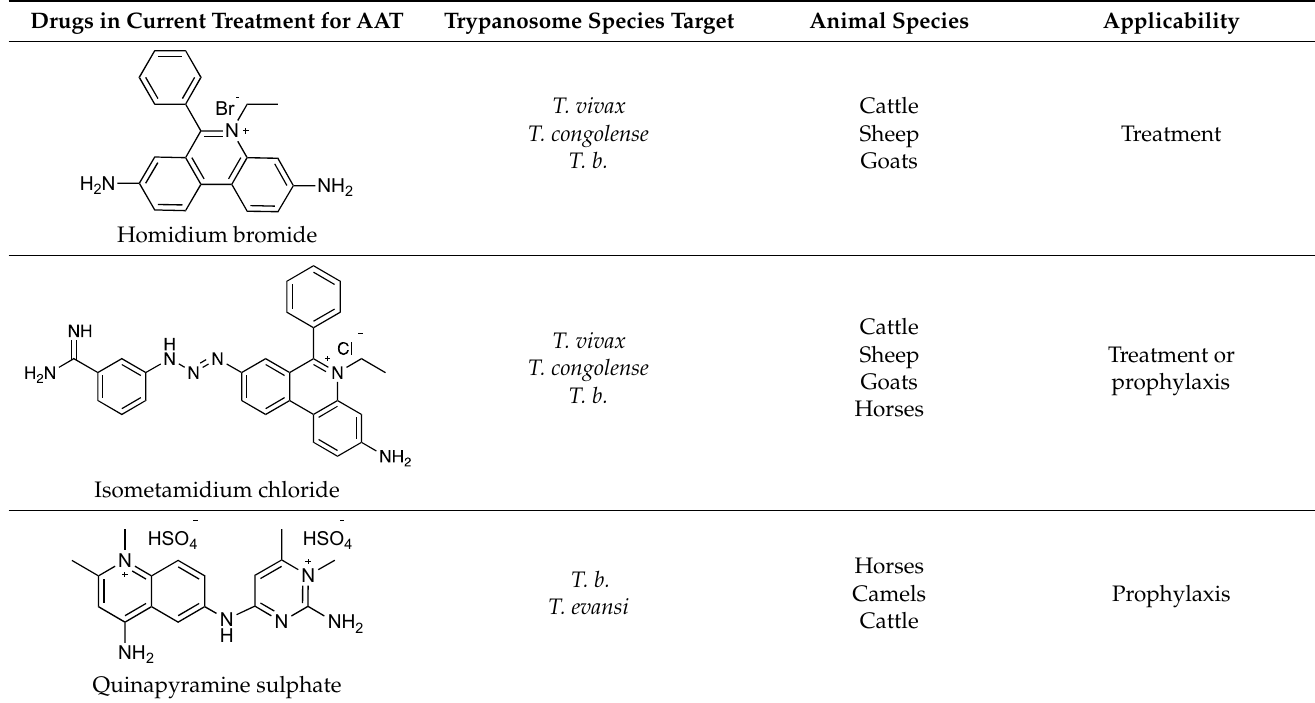
Table 2. Drugs in current treatment for Animal African Trypanosomiasis (AAT). Drugs in Current Treatment for AAT